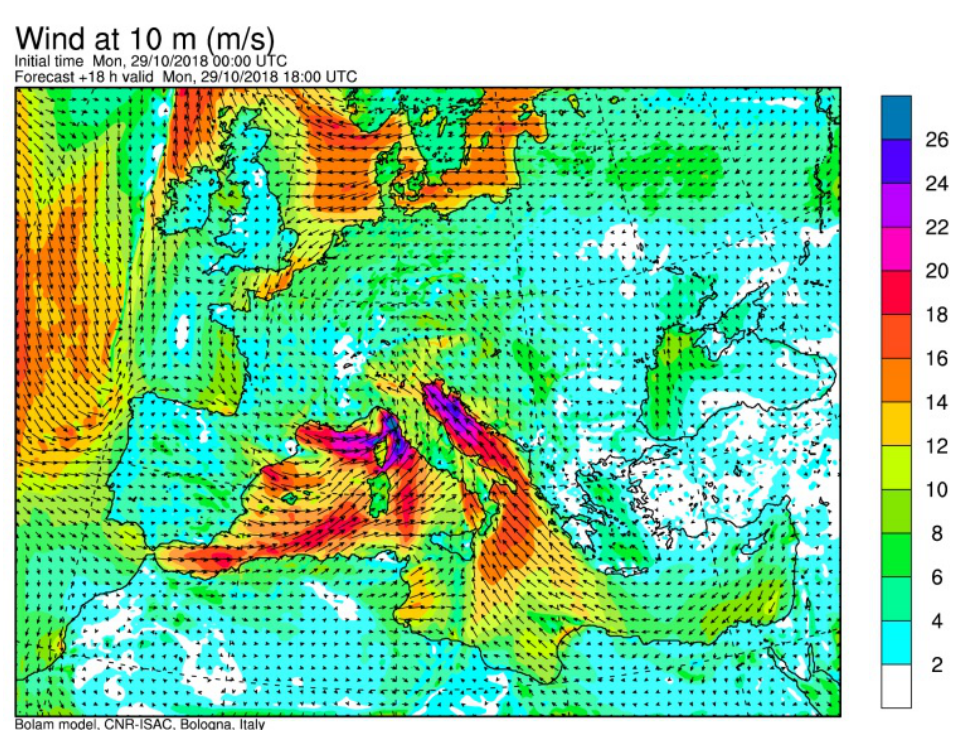
Figure A11. Map of the wind at 10 m height over the Mediterranean basin, as forecast for 29 October 2018 at 6 p.m. by the BOLAM model. The arrows indicate the wind direction and the wind speed is shown in the colour scale.